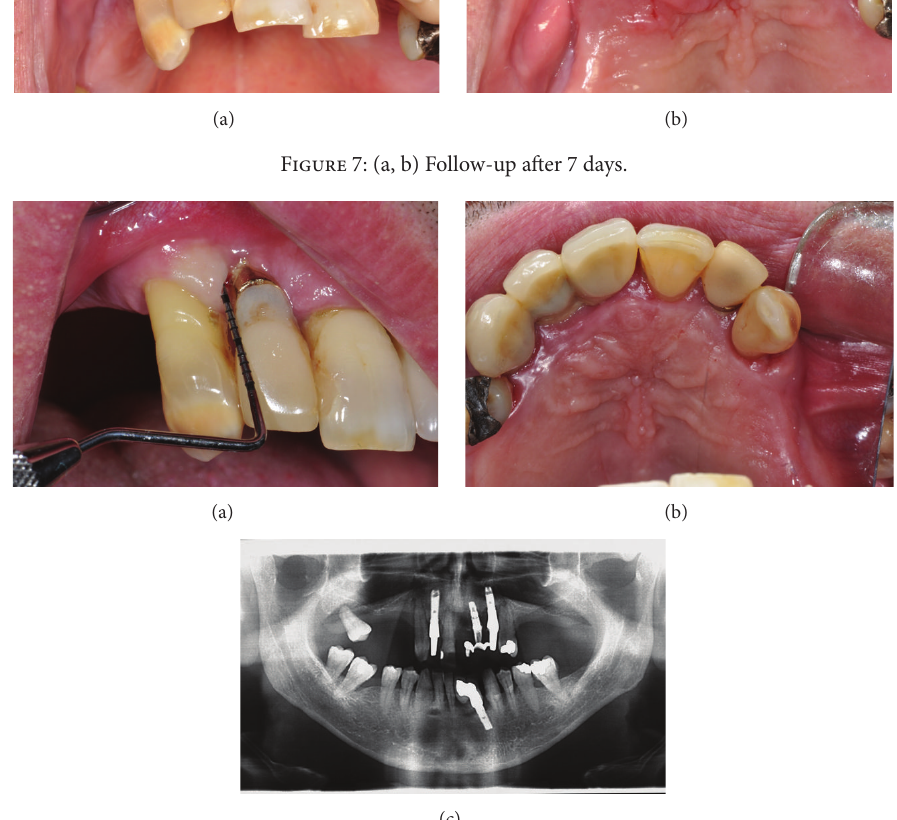
Figure 8: (a, b, c) Clinical and radiological follow-up after 19 months.